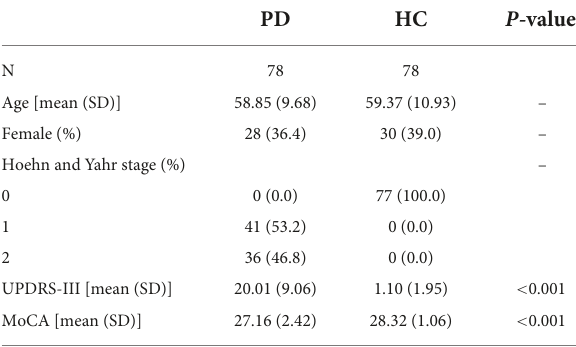
TABLE 2 Demographic and clinical details of patients with Parkinson’s disease and healthy